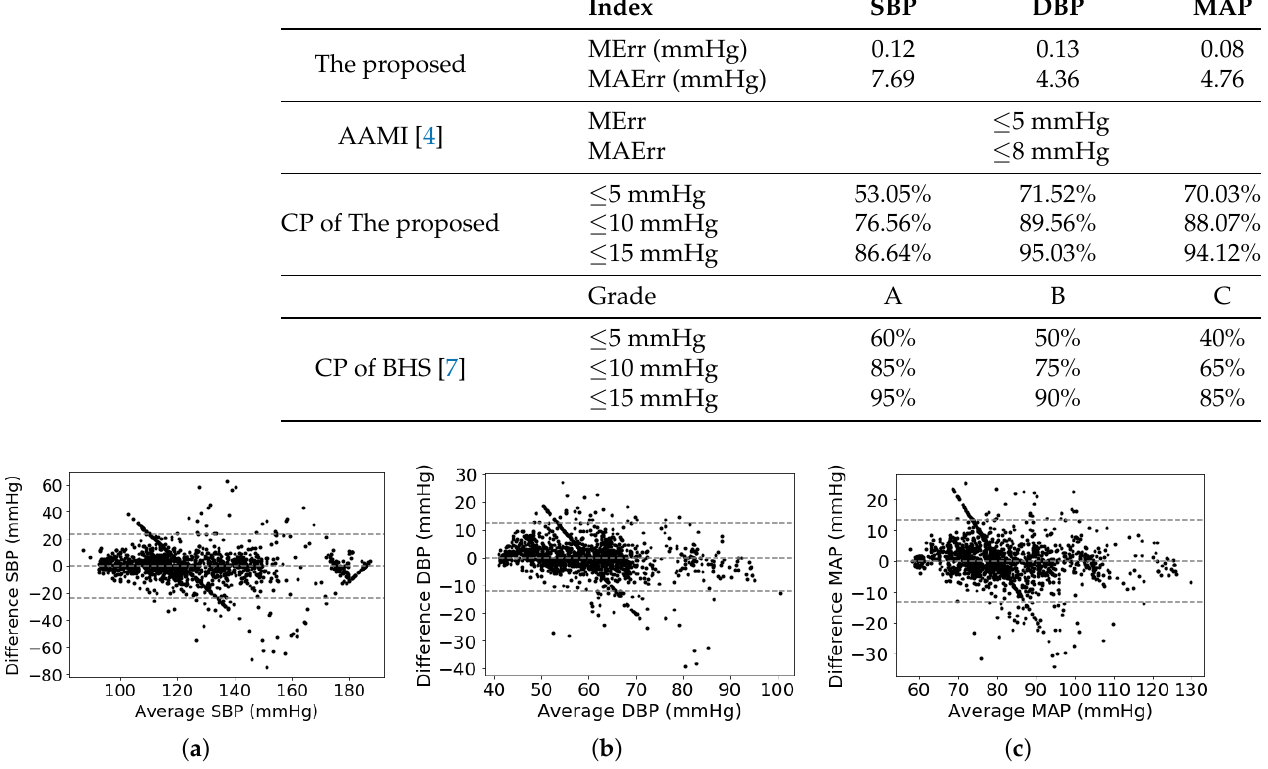
Figure 4. Bland–Altman analysis plots: ( a ) SBP, ( b ) DBP, ( c )